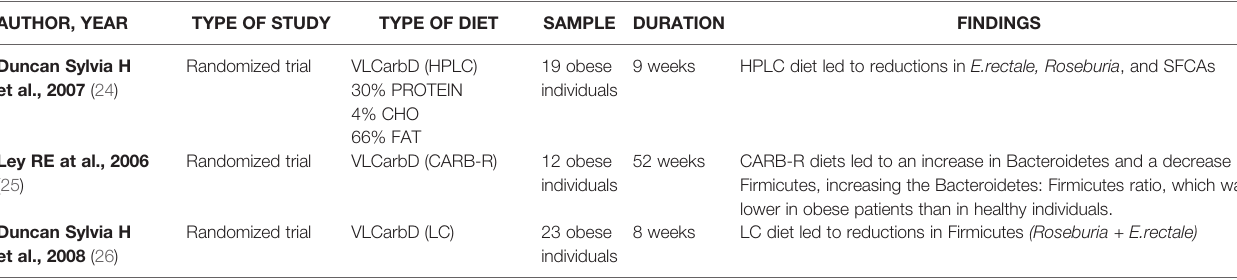
TABLE 2 | Studies on the effects of VLCarbDs on gut microbiota.